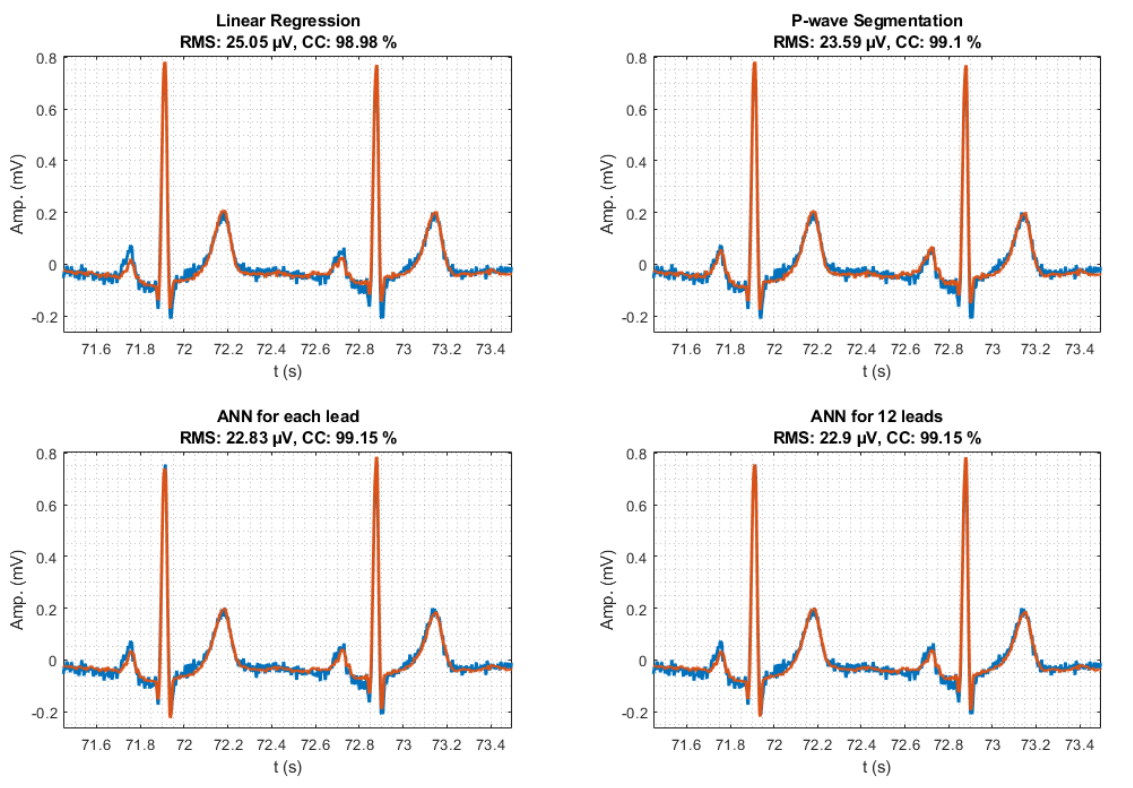
Figure 8. Reconstruction by the described methods of an ECG fragment of lead II of one of the patients. To perform the reconstruction, EASI leads were chosen. Two of the five FoMs, RMS error and CC, are indicated. In blue, the original signal and, superimposed in orange, the reconstructed